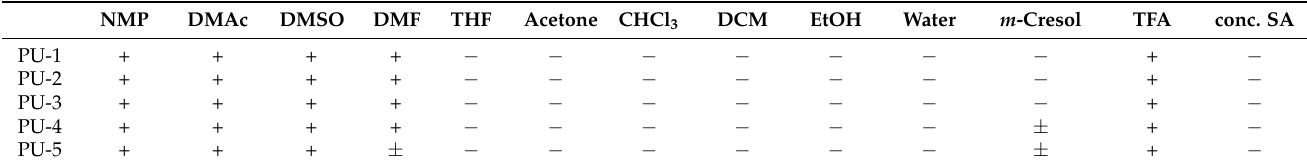
Table 1. Solubilities of the PUs synthesized from various diisocyanates (a)